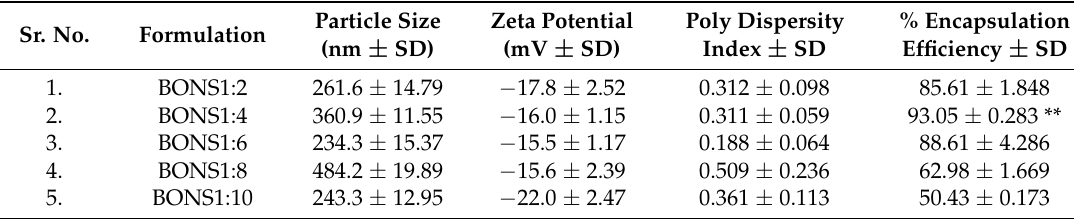
Table 2. Particle sizes, zeta potentials, poly dispersity index, and percentage encapsulation efficiency of the BO formulations ( n = 3, mean ±